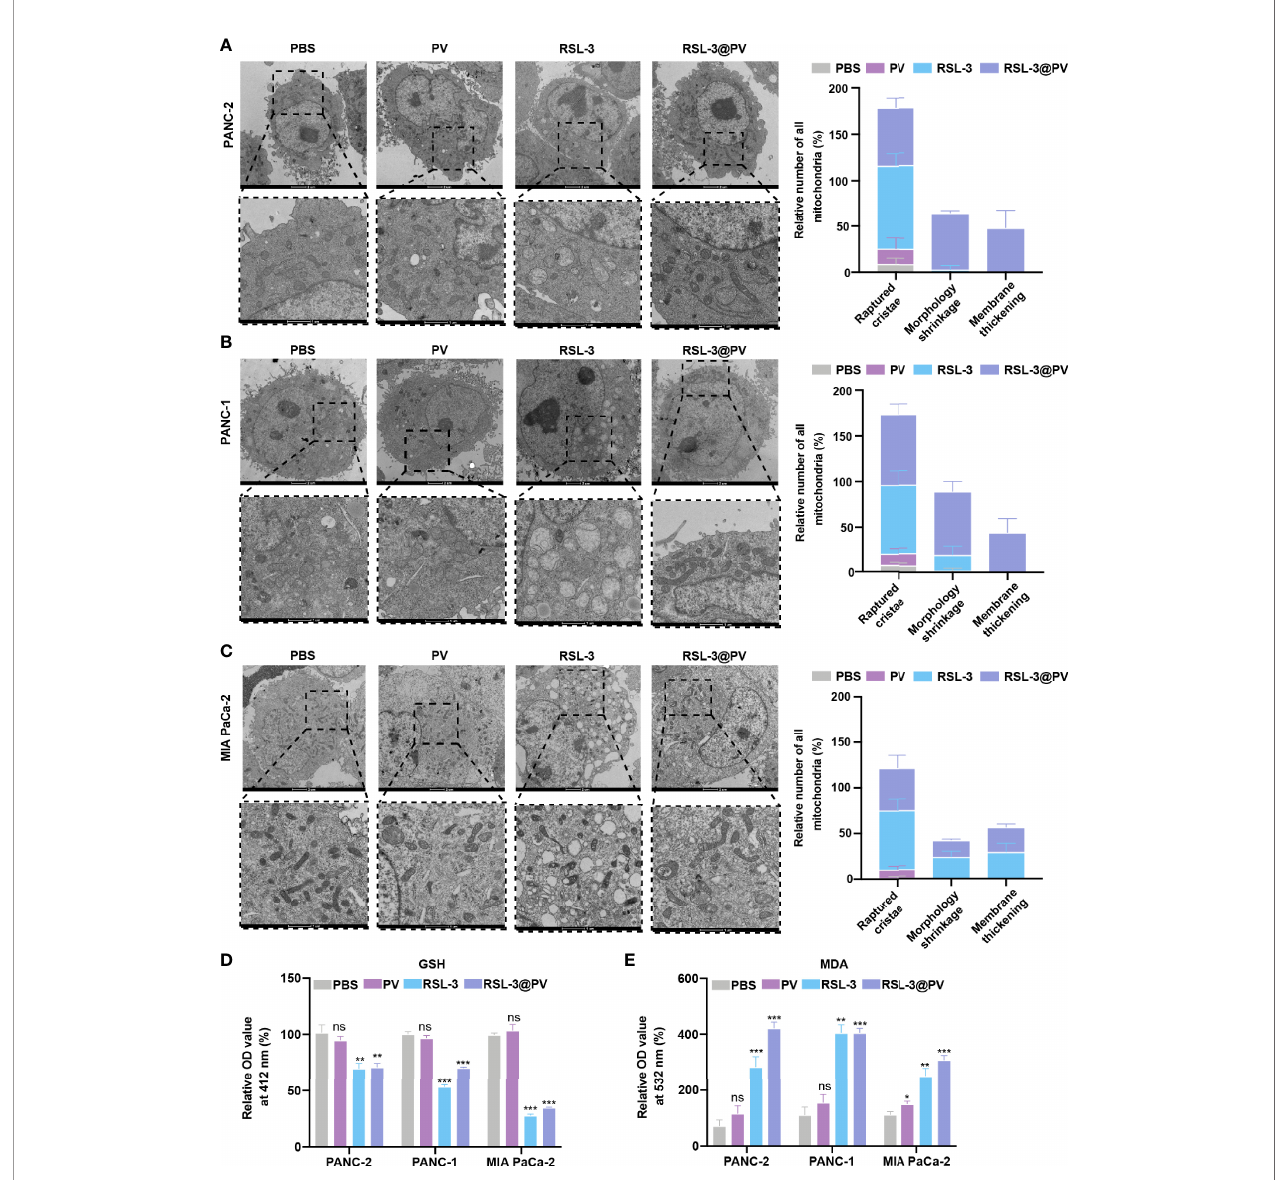
FIGURE 3 | Effects offerroptosis on cell morphology and levels of oxidative stress. (A – C) TEM images and relative number of all mitochondria in PANC-2 (A) , PANC-1 (B) , MIA PaCa-2 (C) treated with PBS, PV, RSL-3 and RSL-3@PVs. Scale bars: 2 m m and 1 m m. (D) Relative OD= 412 nm value in PANC-2, PANC-1, MIA PaCa-2 treated with PBS, PV, RSL-3 and RSL-3@PVs, which characterize the GSH levels. (E) Relative OD = 532 nm value in PANC-2, PANC-1, MIA PaCa-2 treated with PBS, PV, RSL-3 and RSL-3@PVs, which characterize the MDA levels. Error bars represent the mean ± s.d. One-way ANOVA was used for multiple comparisons, ns P >0.05, *P < 0.05, **P < 0.01, and ***P <